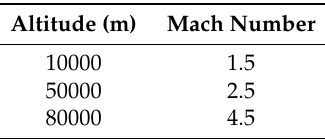
Table 7. Flight speeds at the target altitudes